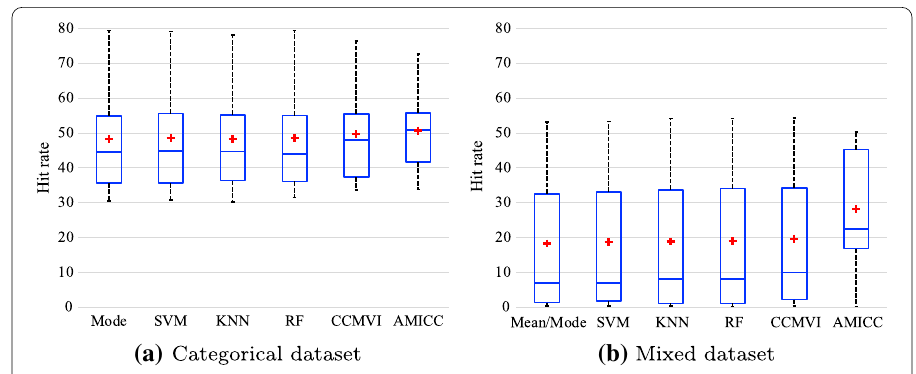
Fig. 17 Boxplots of the average hit rate values for the MVI methods on ( a ) the categorical, and ( b ) the mixed datasets